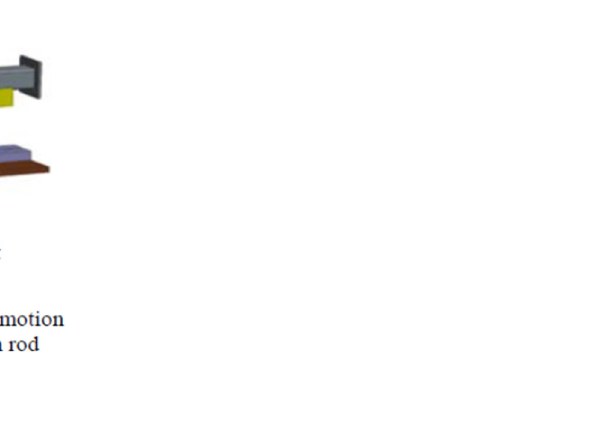
Figure 3. General arrangement of the NTUA tank-scale model with the dynamic wing arranged at the bow.